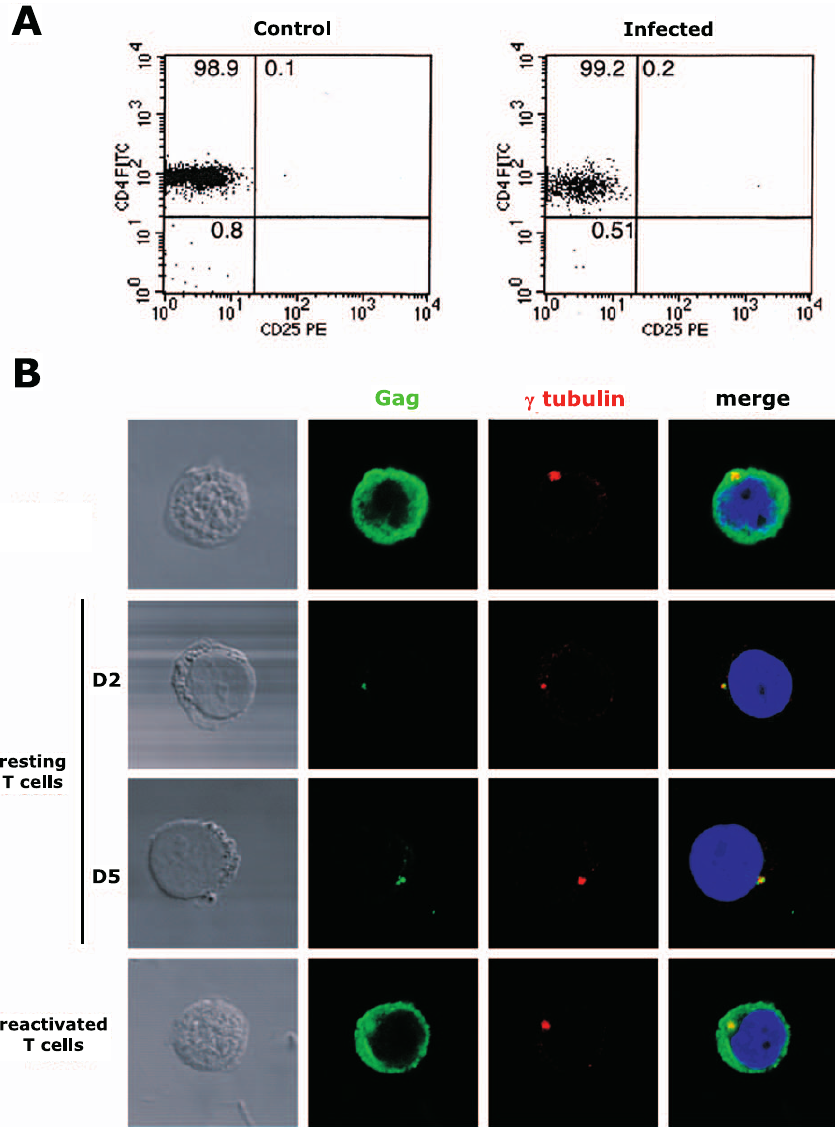
Figure 4. Intracellular Localization of Incoming PFV in Quiescent and Activated CD4-positive T Cells (A) Flow cytometry profile of isolated human resting CD4-positive T cells. Purity of sorted cells is at least 99% and no cell activation is observed 5 d p.i. (B) Sub-cellular localization of Gag proteins studied by confocal microscopy following indirect immunofluorescence using anti-Gag antiserum (green). In activated CD4-positive T cells at 48 h p.i., Gag proteins are not restricted to the MTOC but diffusely localize in the cytoplasm and in the nucleus (top row). In resting CD4-positive T cells at 2 and 5 d p.i., Gag proteins co-localize with c -tubulin (red), the MTOC marker. Twenty-four hours following cell stimulation of 5 d (cid:2) infected resting CD4-positive T cells, Gag proteins diffusely localize in the cytoplasm and in the nucleus, similar to what we observed in activated CD4-positive T cells (bottom